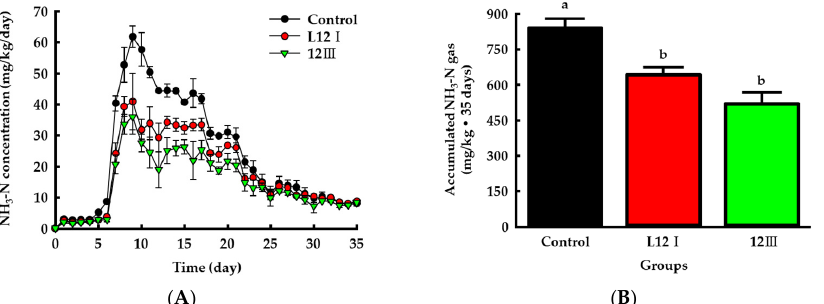
Figure 8. Changes of daily NH 3 gas emission ( A ) and accumulated NH 3 gas ( B ) in the livestock manure by treating selected bacterial strains. Values represent the mean ± S.E. ( n = 3). The different letters (a, b) indicate statistically significant difference between groups (significance level at p < 0.05).